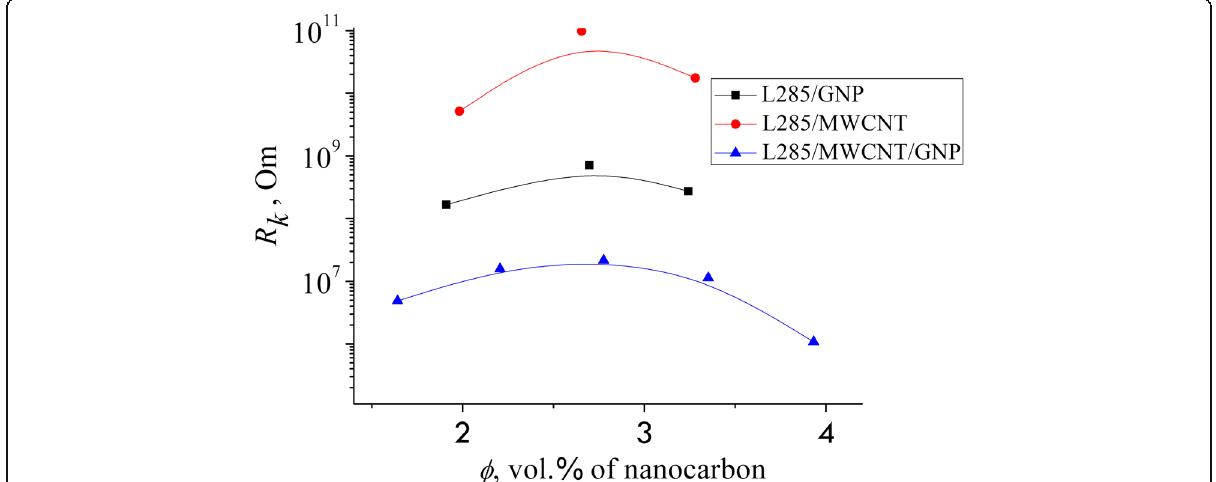
Fig. 6 Contact resistance R k of the studied CMs, which was calculated by using Eq. (3)